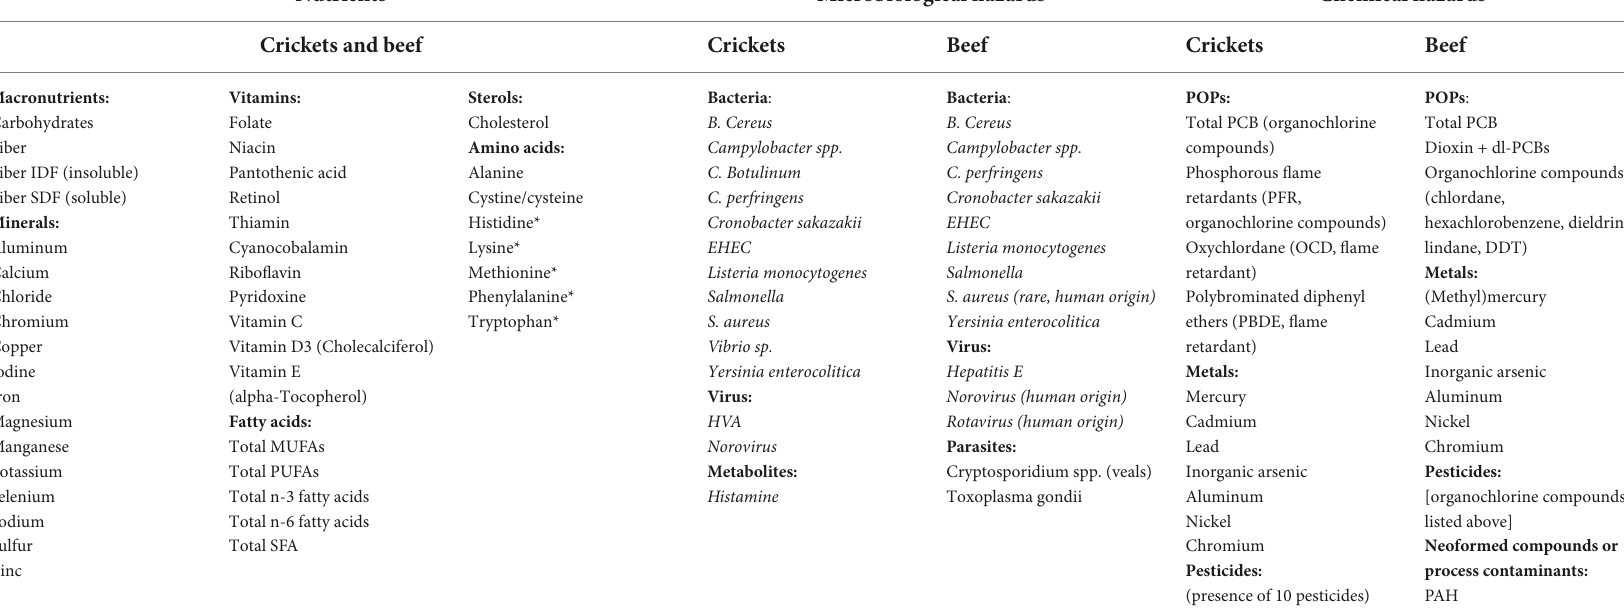
TABLE 2 The “long” list of components identified in beef meat and crickets (selection made through the NovRBA case study). Nutrients Microbiological hazards Chemical hazards Crickets and beef Crickets